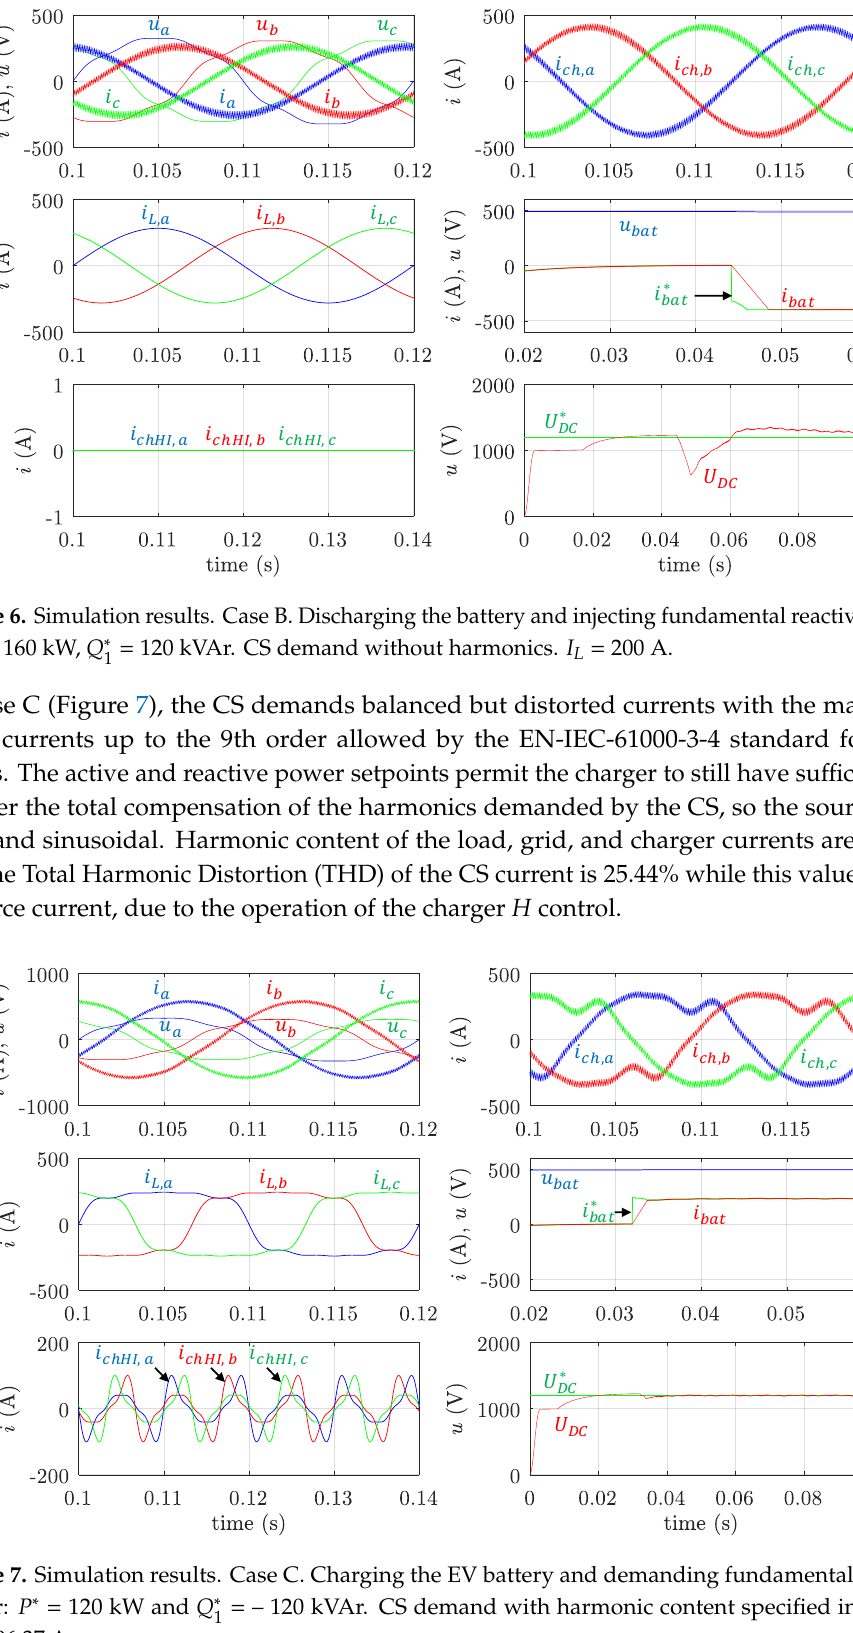
Figure 5 . Simulation results. Case A. Charging the EV battery at maximum power: 𝑃 ∗ = 200 kW. CS demand without harmonics nor imbalance: 𝐼 𝐿 = 200 A.